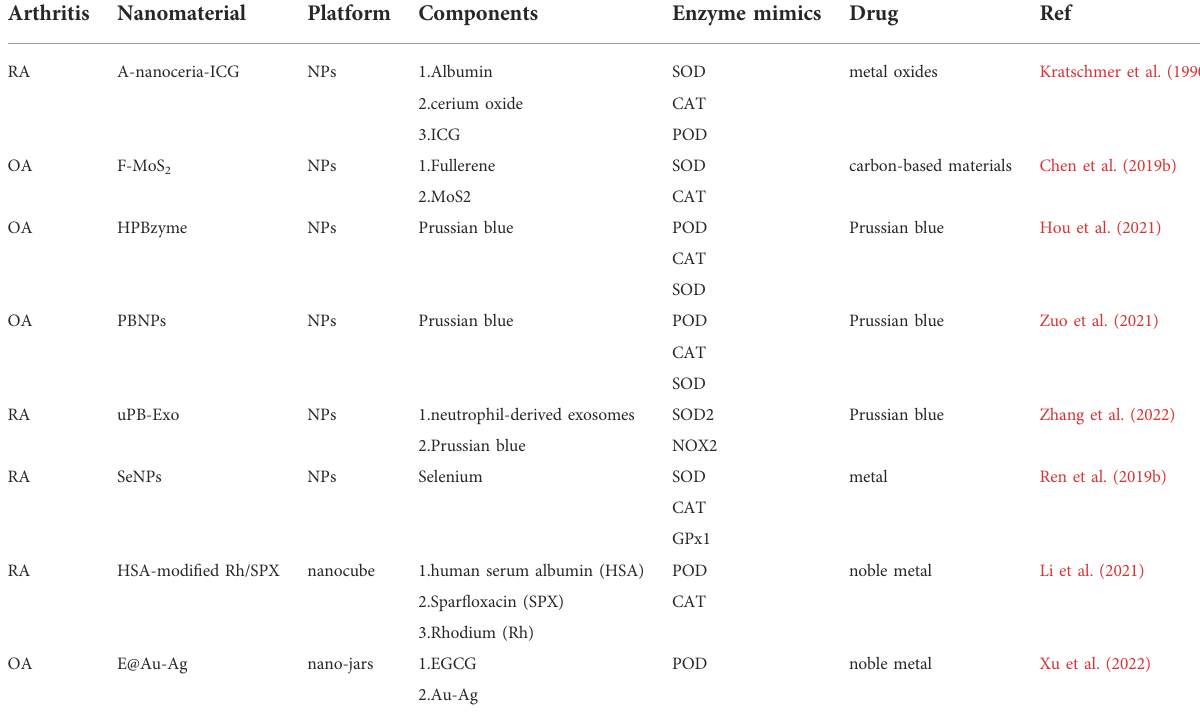
TABLE 2 Biomaterials that mimic the downregulated enzymes in arthritis.